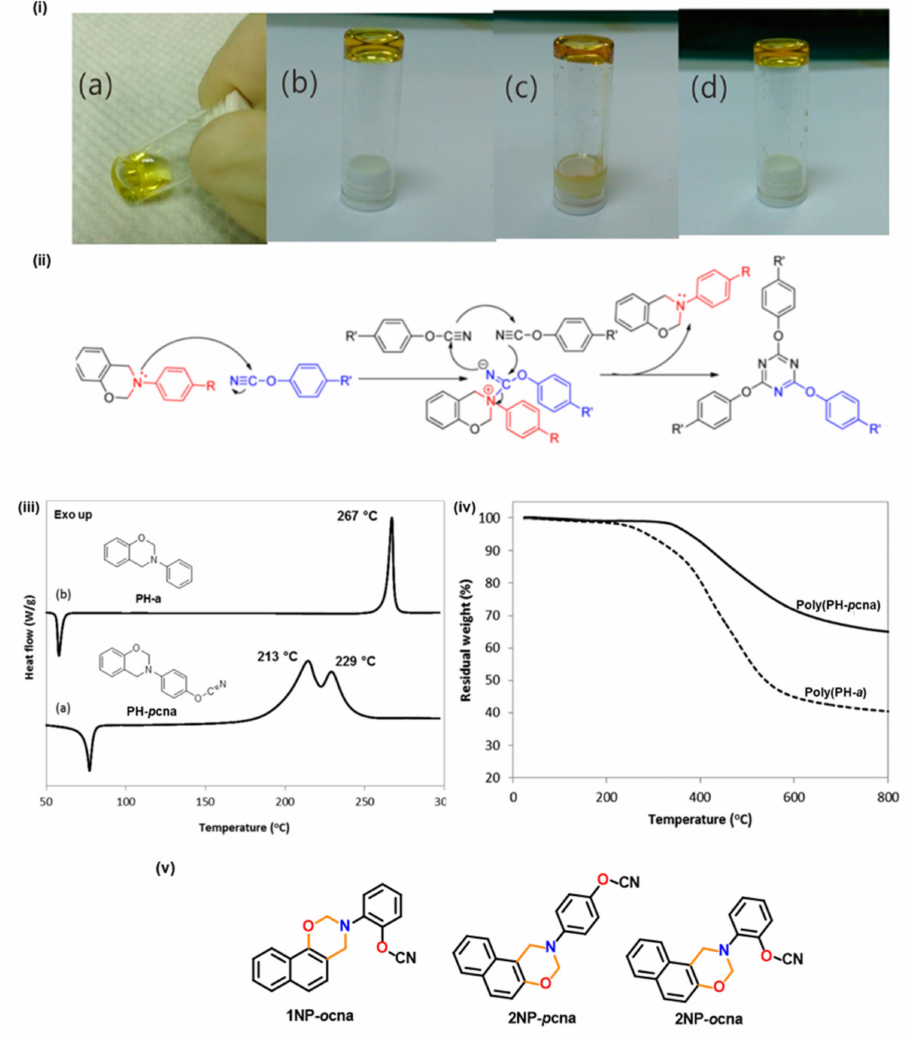
Figure 14. ( i ) Digital images of a 50 wt% methyl ethyl ketone solution of PH-oda/BADCY (Bisphenol A dicyanate ester) (1/1, mol/mol): ( a ) freshly prepared solution, and the thermally treated solution at ( b ) 30 ◦ C for 24 h, ( c ) 50 ◦ C for 4 h and ( d ) 100 ◦ C for 2 h [178]. ( ii ) Proposed catalytic mechanism